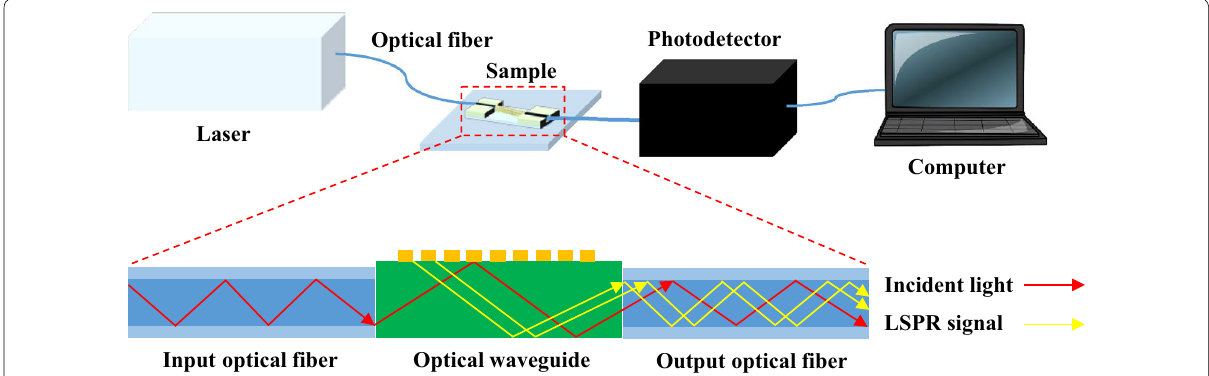
Fig. 4 The optical measurement set‑up and the schematic diagram of lights pass in OWG